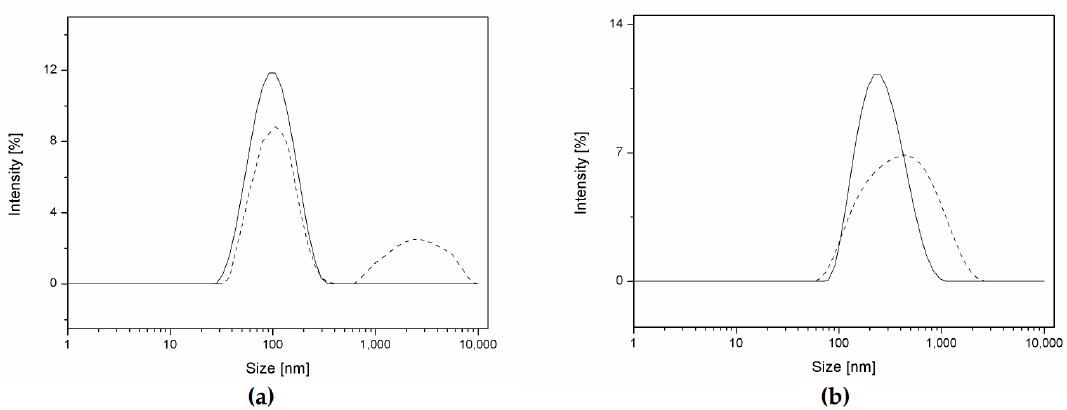
Figure 4. Evolution of the particle size distribution in cell medium during degradation. ( a ) Sample 20CL 3 at 0 h (solid line) and after 48 h (dashed line). ( b ) Sample 20CL 3 PEG at 0 h (solid line) and after 216 h (dashed line).